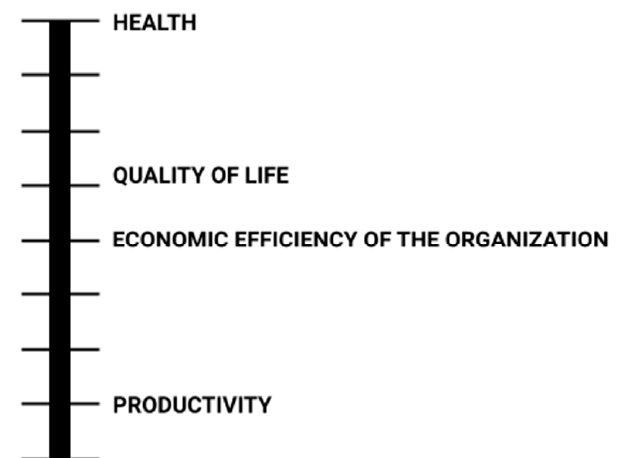
Figure 2. Hierarchy of criteria. Source: own elaboration.